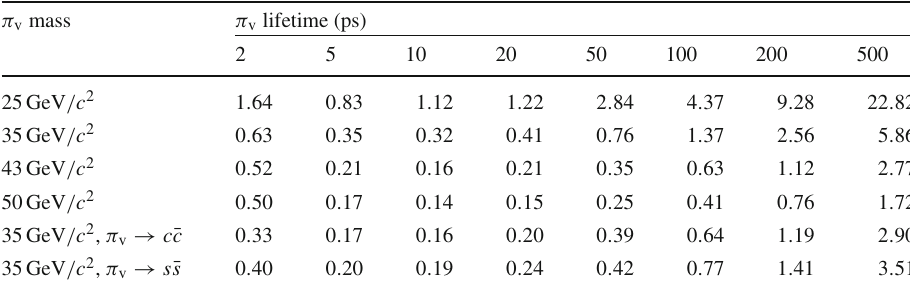
Table 4 Observed 95% CL signal strength ( μ ) upper limits for different π v models